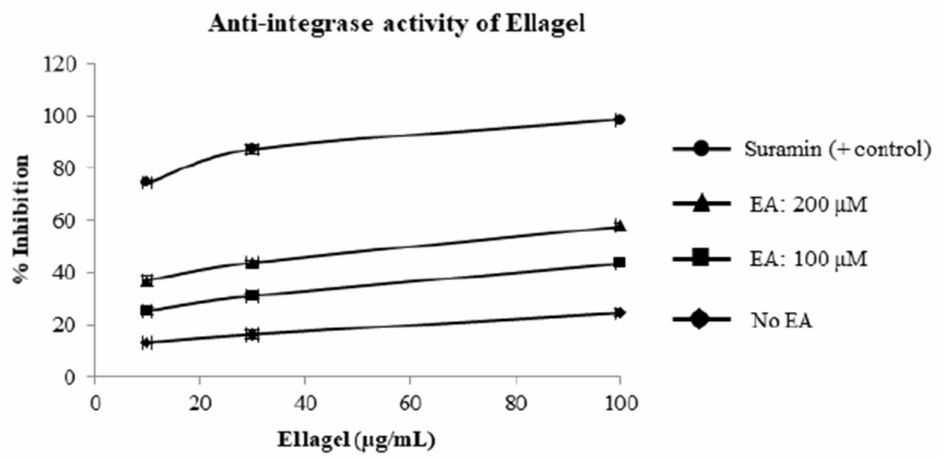
Figure 6. Percent inhibition of in vitro HIV integrase activity by Ellagel. Two different formulations of Ellagel, containing either 100 µ M or 200 µ M ellagic acid (EA), were tested. Effects of Ellagel on HIV-1 integrase activity were determined using an in vitro integration assay, in which digoxigenin-labelled target DNA was incubated with HIV-1 integrase and plate-bound HIV-long-terminal repeat (LTR) DNA in the presence or absence of Ellagel. After incubation and washing, DNA integration was detected by an alkaline phosphatase-labeled anti-digoxigenin antibody. The optical density (OD) of the AP-labeled antibody was measured at 405 nm. Anti-HIV-1 integrase activity was calculated as follows: % Anti-HIV-1 integrase activity = [(OD control − OD sample)/(OD control)] × 100. Mean % inhibition ± standard deviation of four replicates is shown in the